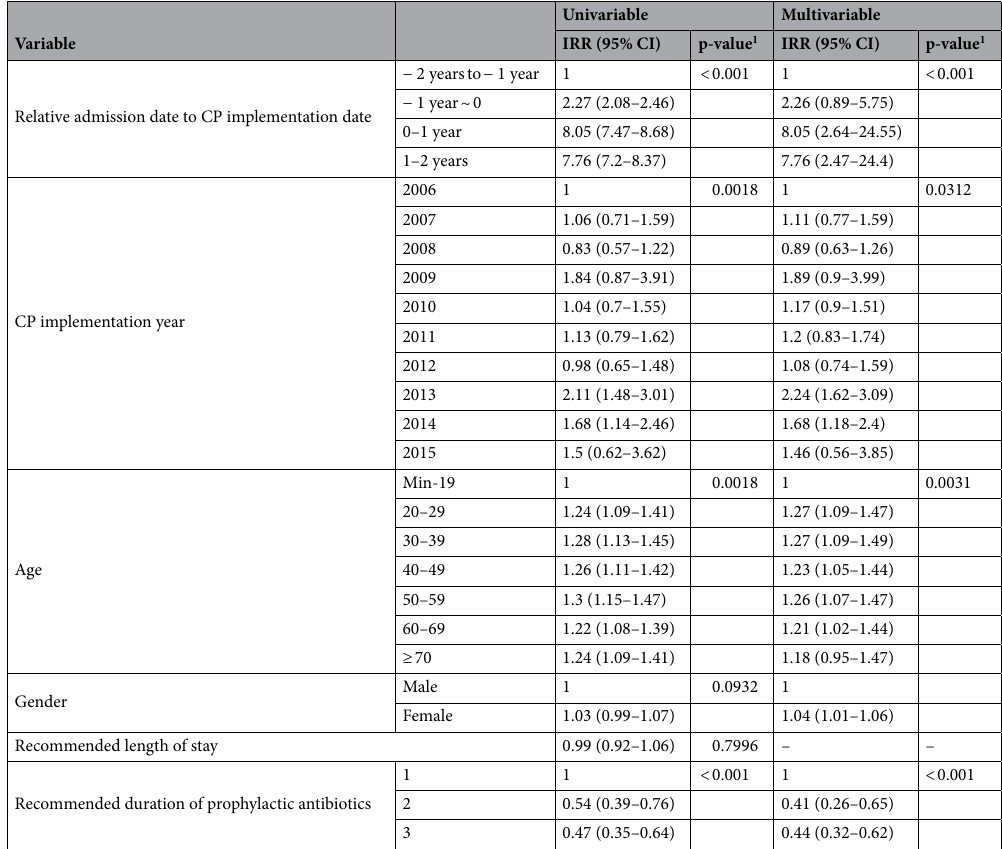
Table 2. Effects of clinical pathway (CP) implementation on the adherence rate (n p = 44,062), and the incidence rate ratio (IRR) from the univariable and multivariable mixed-effect Poisson model with random effects. CI confidence interval. 1 p-value calculated using the log likelihood ratio test.